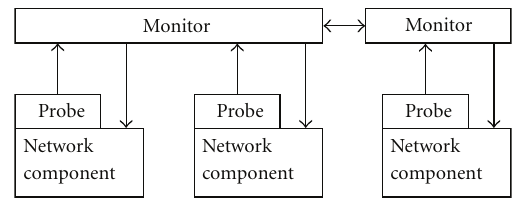
Figure 1: Network